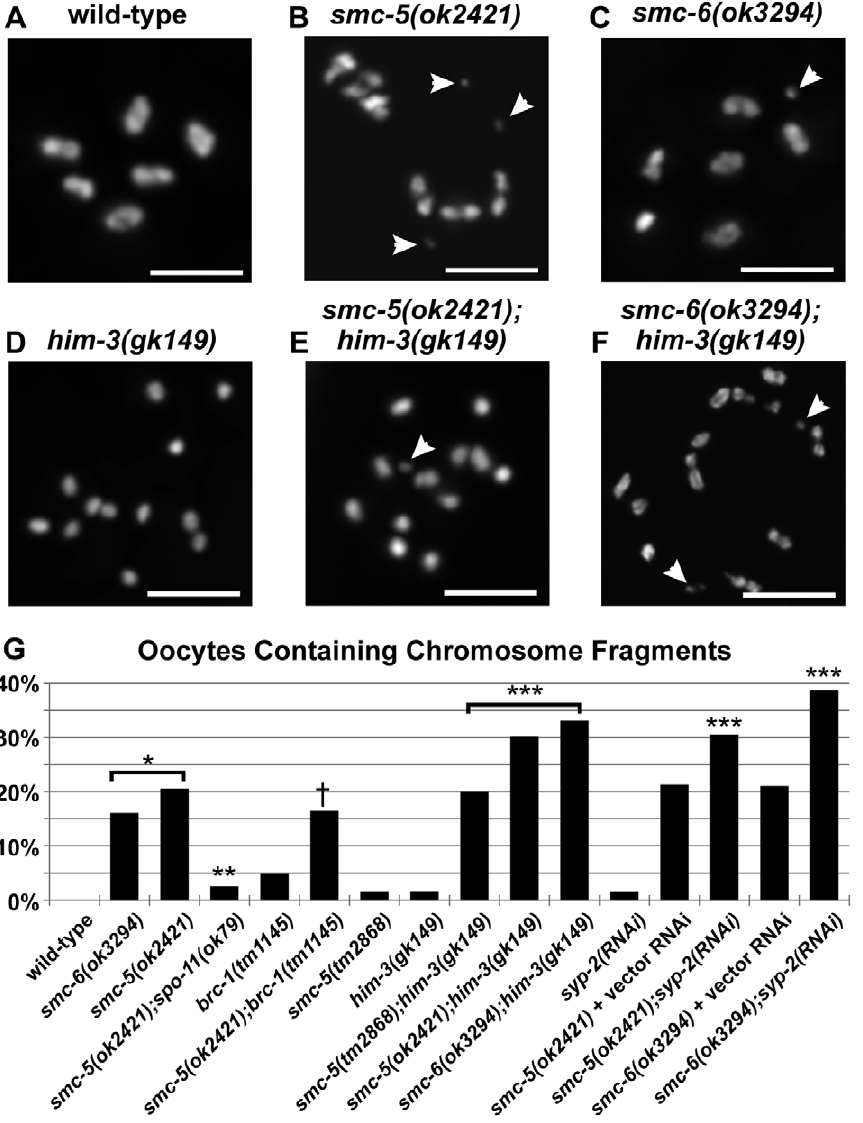
Figure 7. Chromosome fragmentation defects linked to homolog-independent repair of meiotic DSB. (A–F) Micrographs of DAPI- stained diakinesis chromosomes are shown at the same magnification. Chromosomal fragments are indicated by white arrowheads, and scale bars=5 m m. (G) A graph of the percentages of diakinesis oocytes containing chromosome fragments. The smc-5(ok2421) and the smc-6(ok3294) mutant oocytes showed significantly higher frequency of chromosome fragmentation over wild-type (*p , 0.001, Fisher’s Exact Test). The smc- 5(ok2421) fragmentation defect was drastically suppressed by the spo-11(ok79) mutation (**p=0.006). The disruption of inter-homolog recombination by destabilizing homolog-synapsis consistently enhanced the fragmentation defects in all three smc-5 and smc-6 mutant strains (***). By contrast, the brc-1 mutation affecting sister-chromatid recombination [7] failed to enhance the fragmentation defect of the smc-5(ok2421) mutation ( { ). The numerical values, sample sizes, and statistical comparisons are summarized in Table